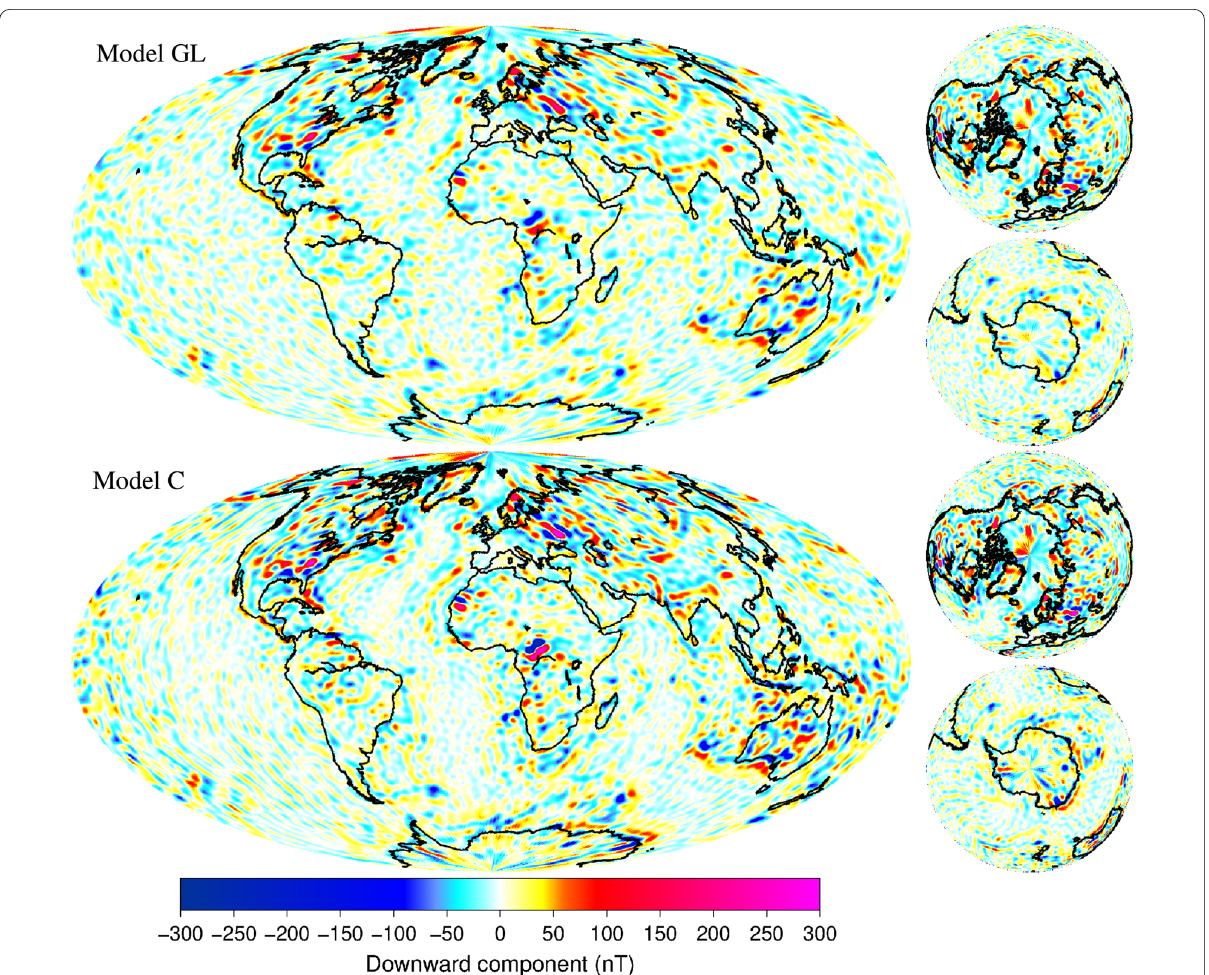
Fig. 14 Downward component of the lithospheric field at the Earth’s surface expanded up to spherical harmonics degree ℓ = 100 . Top: model GL derived from GOCE data alone. Bottom: model C derived from CHAMP